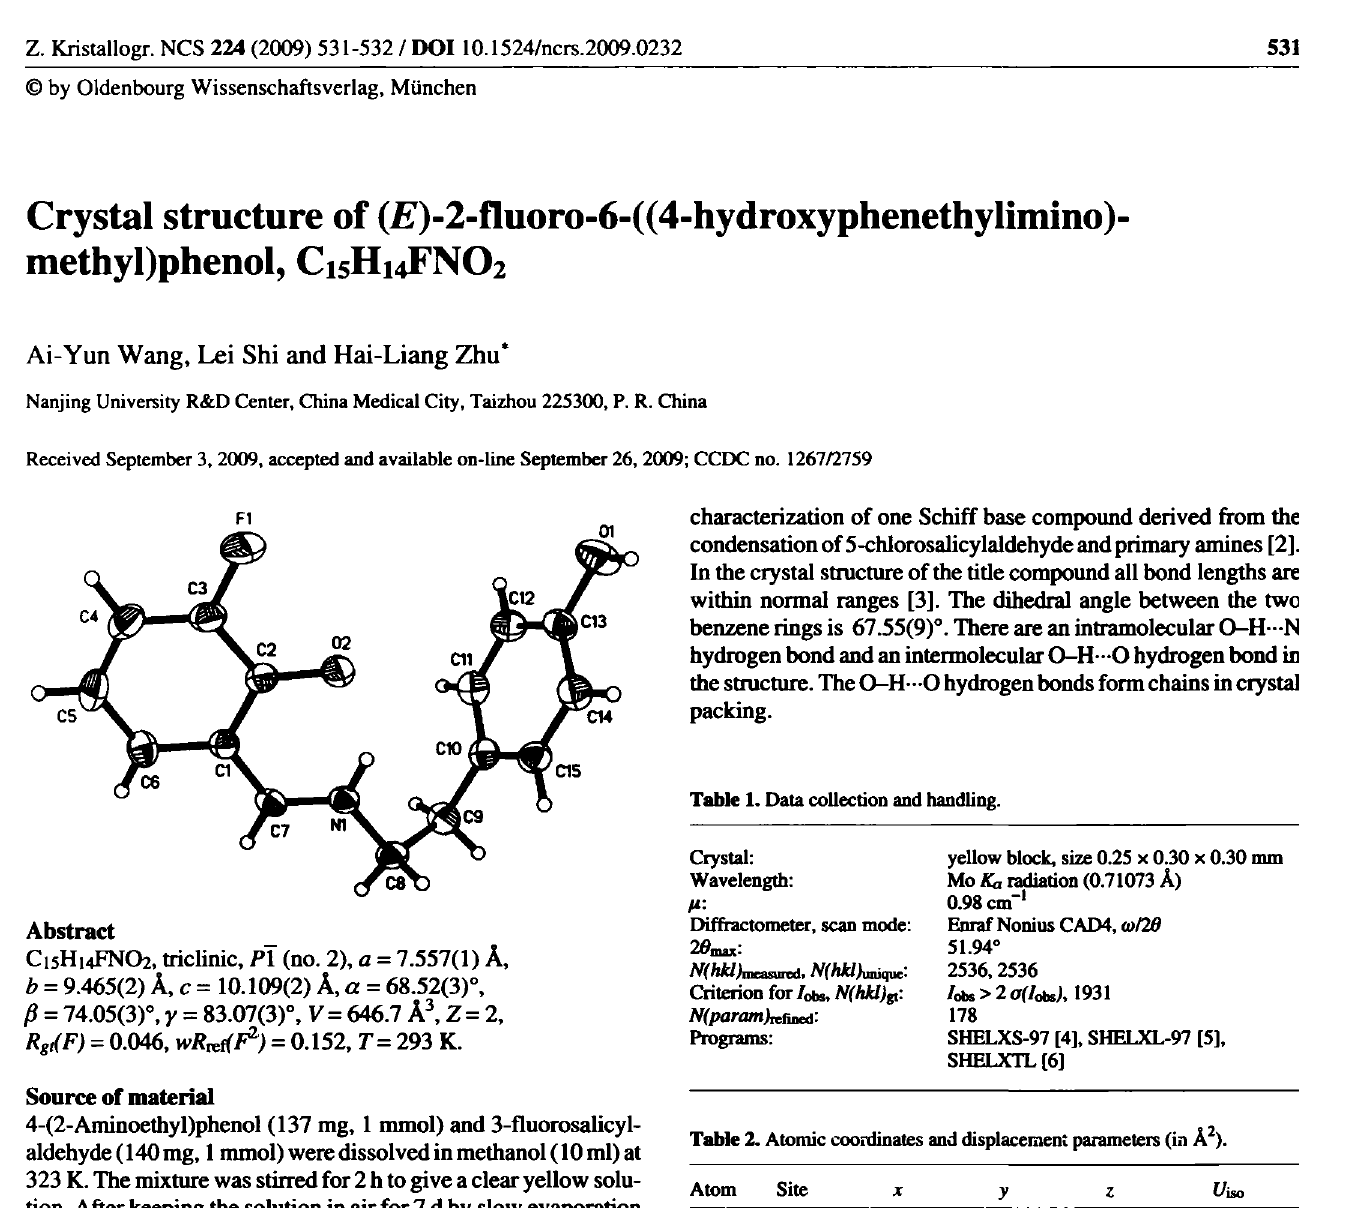
Table 2. Atomic coordinates and displacement parameters (in Â 2